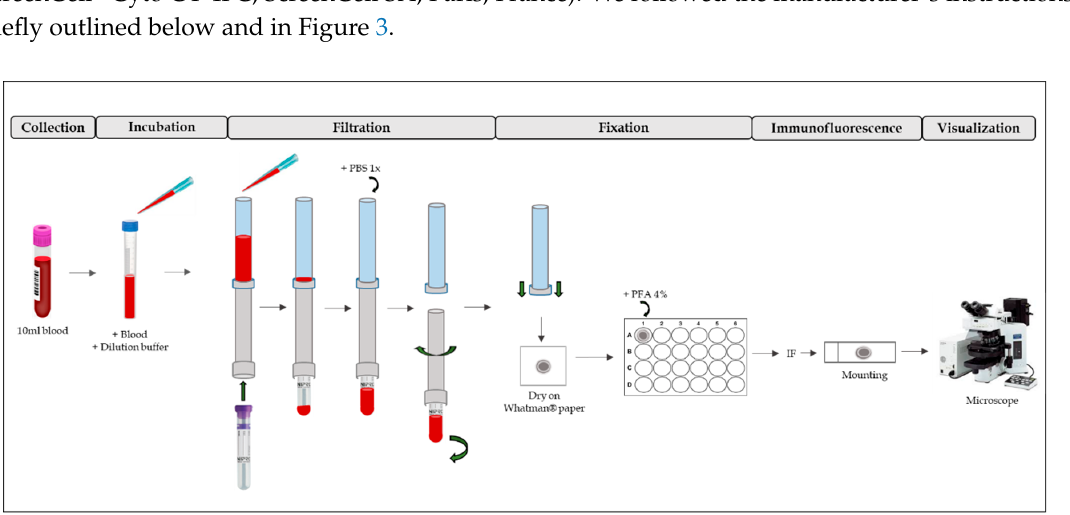
Figure 3. ScreenCell ® Cyto Technology process. First, blood is collected and mixed with dilution buffer (Incubation). After, there is a filtration process, washing and fixation with PFA 4%. Then, IF can be performed on the filter. After mounting, the IF is visualized by a fluorescence microscope. PBS: phosphate buffered saline; PFA: paraformaldehyde; IF: immunofluorescence.